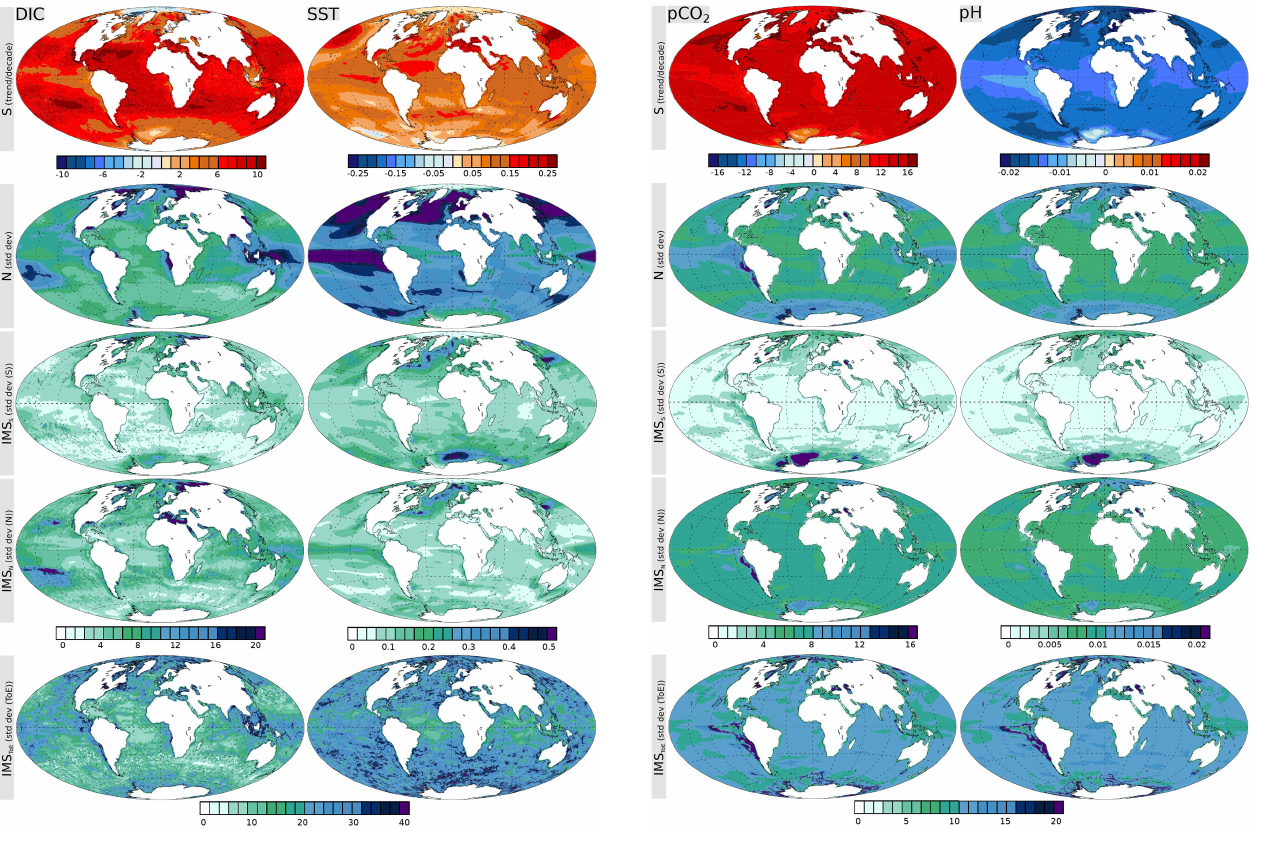
Figure 3a. Trend per decade ( S ), standard deviation ( N ) and, as measures for the inter-model spread (IMS), standard deviations of S (IMS S ), N (IMS N ), and ToE (IMS ToE ; years) of dissolved inor- ganic carbon (DIC; mmolm − 3 ) and sea-surface temperature (SST; ◦ C).